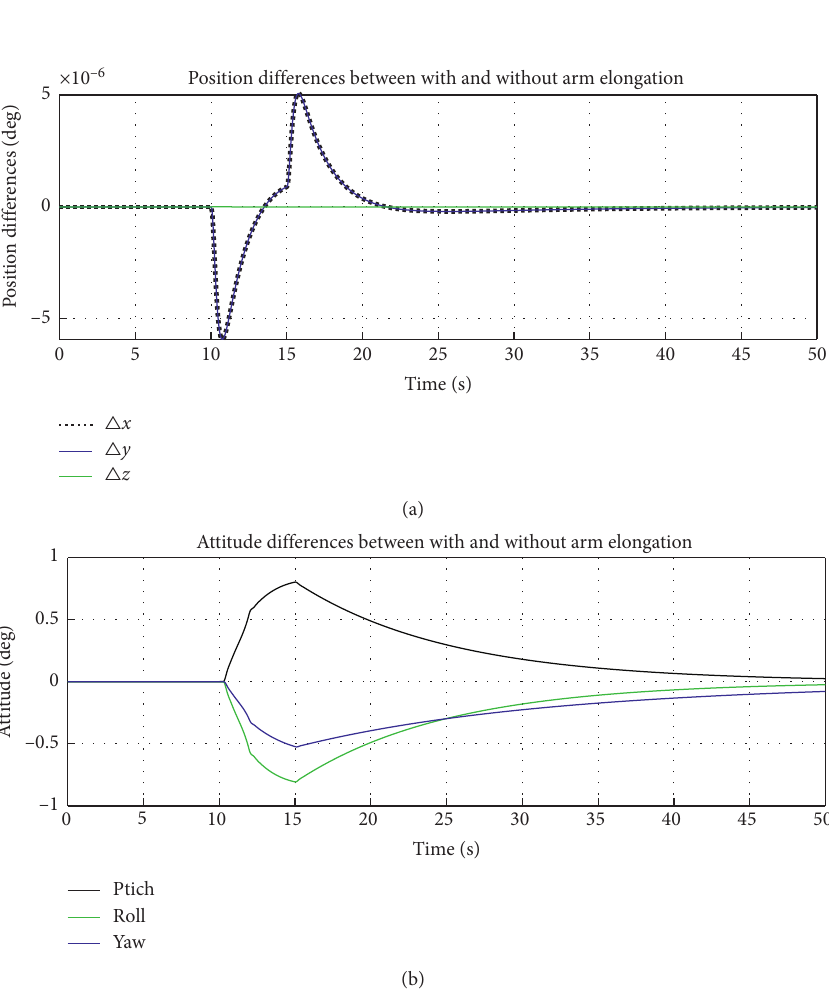
Figure 5: Curve of single-arm elongation.